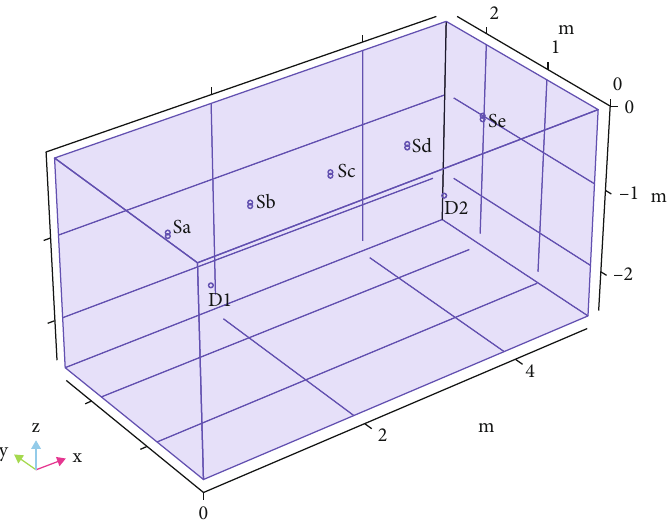
Figure 2: Subsurface smart irrigation system geometry with sensors and di ff users. Table 2: Description and positioning of smart irrigation sensors.